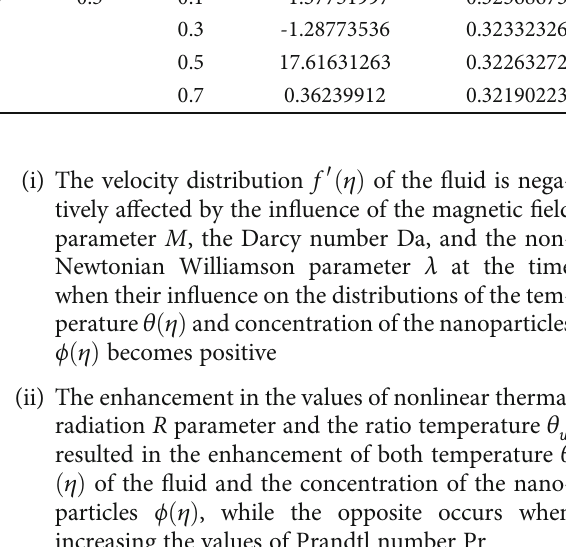
Figure 24: Local Nusselt number pro fi le for di ff erent values of S , R .